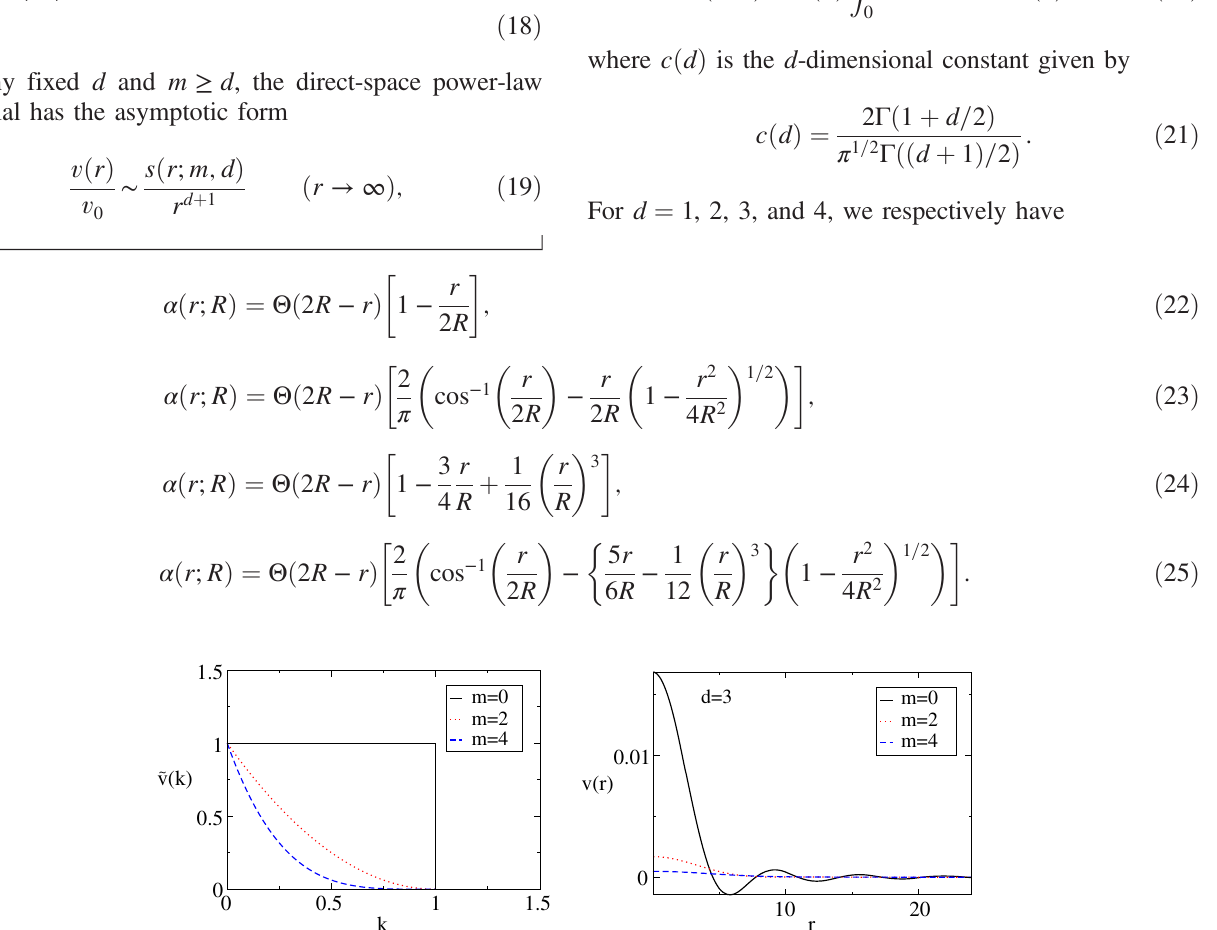
FIG. 4. Left panel: Fourier power-law potential ~ v ð k Þ for the special cases m ¼ 0 , 2, and 4 that apply for any d . Right panel: Corresponding direct-space power-law potentials v ð r Þ in the instance d ¼ 3 . Here, we set v 0 ¼ K ¼ 1